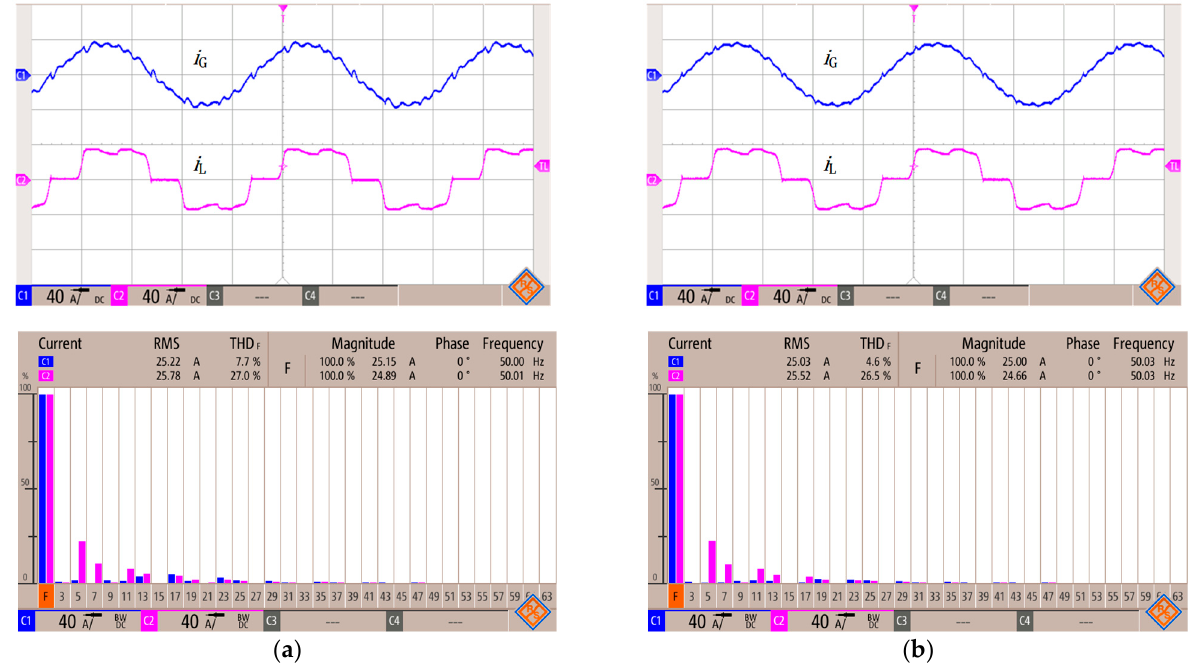
Figure 17. The effect of the time delay compensation on current waveforms and their spectra: ( a ) operation of HAPF without the time delay compensation; ( b ) operation of HAPF with the time delay compensation.